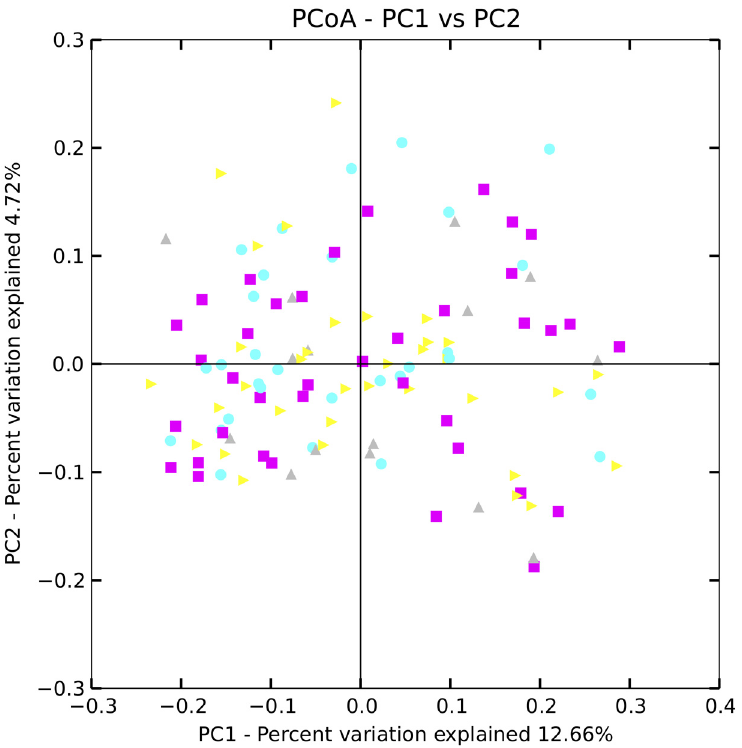
Fig 2. Beta diversity according to the ancestral HLA haplotype AH8.1 status. A principal coordinate plot of the beta diversity measure unweighted unifrac shows all samples colored according to the HLA genotype groups. There were no significant differences between the groups. Yellow : AH8.1 homozygous, i.e. homozygosity for both HLA-B * 08 and HLA-DRB1 * 03. Violet : AH8.1 heterozygotes, i.e. at least 1 copy of HLA-B * 08 and HLA-DRB1 * 03. Turquoise : Non AH8.1 heterozygotes, i.e. HLA-B * 08 and HLA-DRB1 * 03 both not present. Grey : HLA-DRB1 homozygous but non AH8.1.